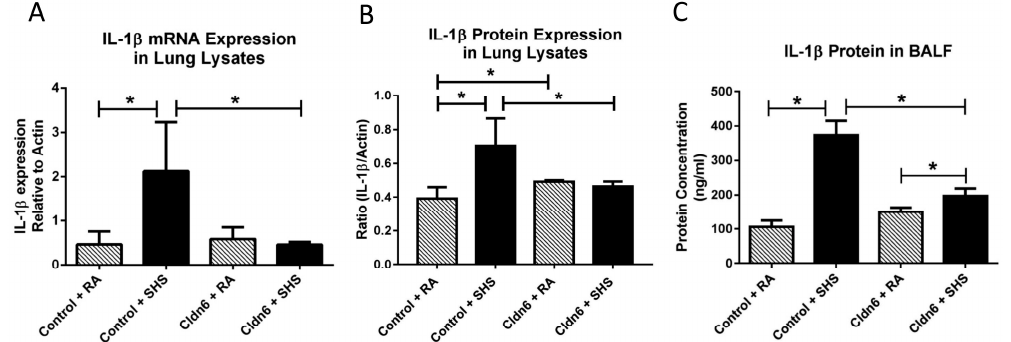
Figure 5. IL-1 β mRNA ( A ) and protein ( B ) were assayed in whole lung lysates by qPCR and immunoblotting, respectively. SHS increased IL-1 β transcription and translation in control animals, but expression of both message and protein were unchanged in SHS-exposed Cldn6 TG mice; ( C ) ELISAs were used to detect secreted IL-1 β in BALF. Despite significant increases in the secretion of IL-1 β following SHS exposure, there was significant inhibition of IL-1 β in Cldn6 TG mice exposed to SHS when compared to SHS-exposed controls. Data are representative of experiments involving six mouse lung samples per group and * p ≤ 0.05.